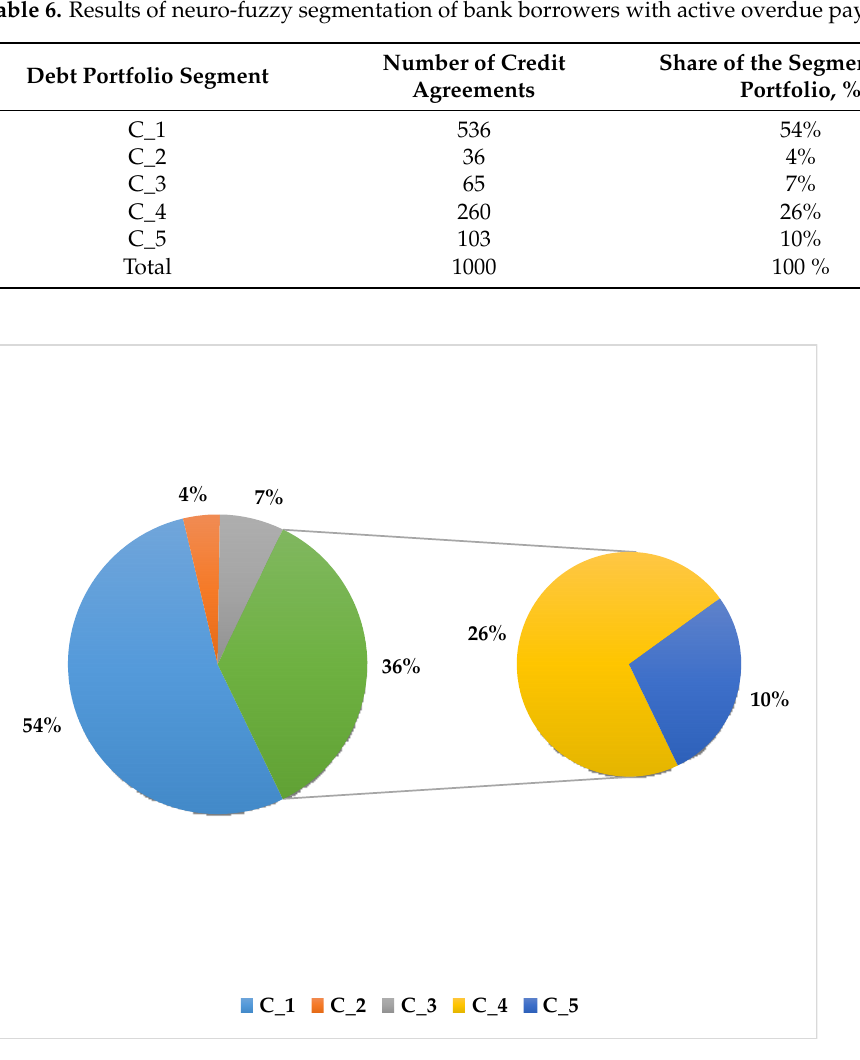
Figure 3. Portfolio of overdue credits based on the results of neural processing (in quantitative terms), %. terms),